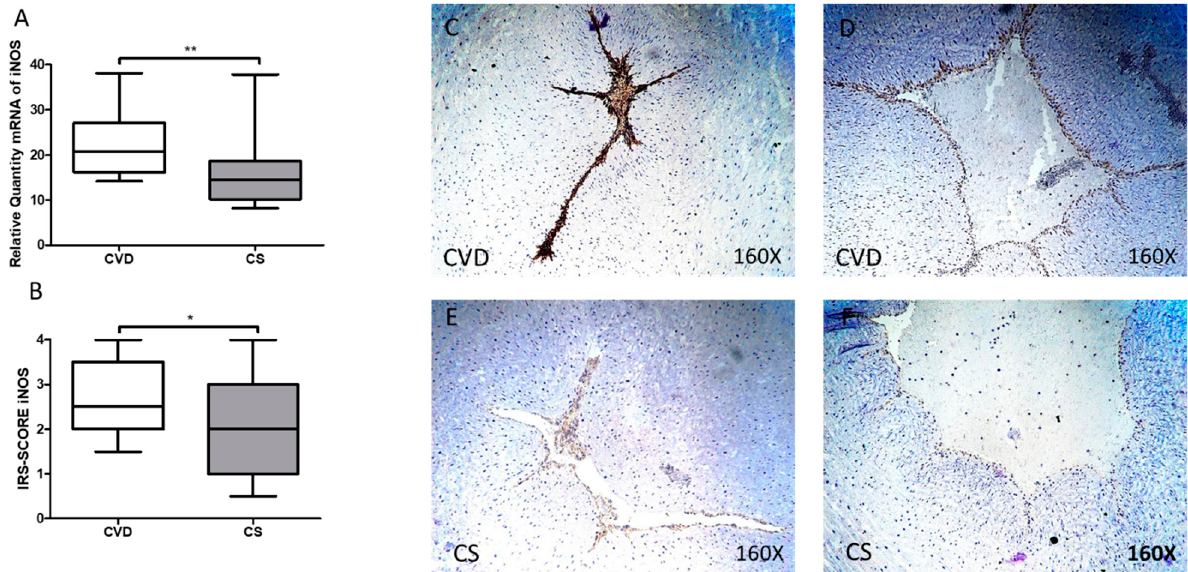
Figure 4. ( A ) mRNA expression levels for iNOS by RT-qPCR in the umbilical cord. ( B ) Levels of IRS-Score quantification in the umbilical cord. ( C – F ) Images showing the immunoexpression of iNOS in the umbilical cord. CVD = Newborns of women diagnosed with chronic venous disease during pregnancy. CS = Control without venous pathology, p < 0.05 (*) and p < 0.01 (**).